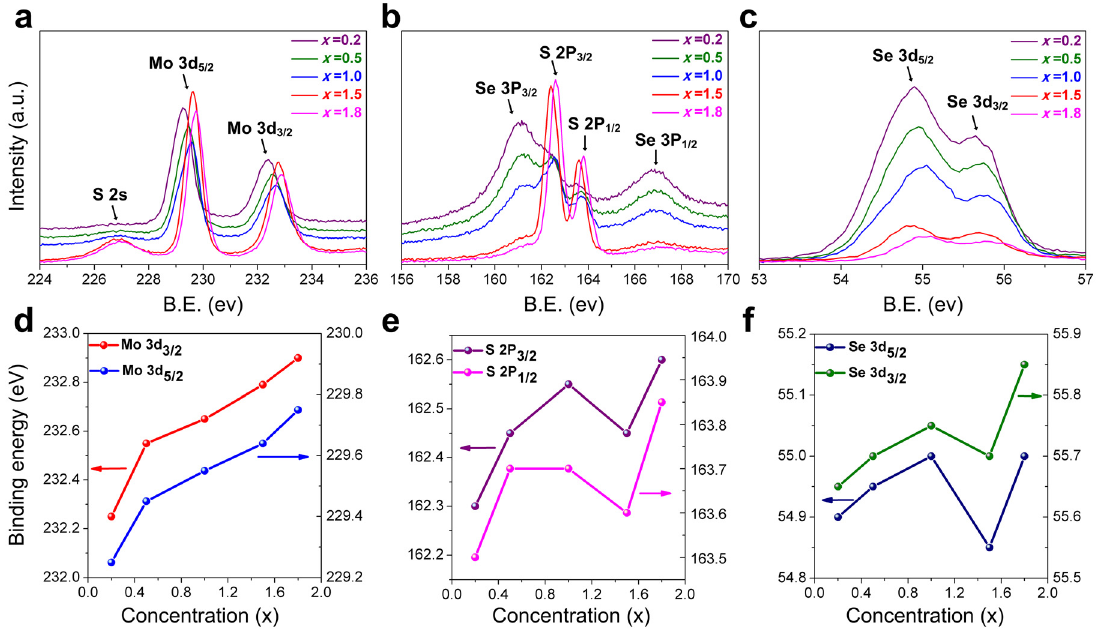
Figure 2: XPS spectra of (a) Mo 3 d , (b) S 2 p, and (c) Se 3 d regions corresponding to MoS x Se 2 − x with different x values. (d) – (f) Plots of binding energy of the primary characteristic peaks as function of x